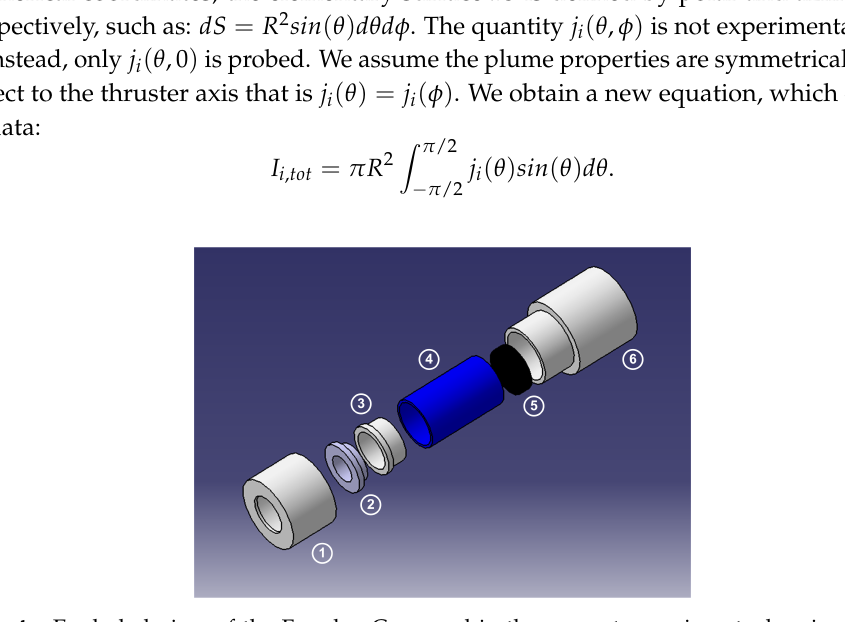
Figure 4. Exploded view of the Faraday Cup used in the present experiment, showing the main elements (see [29] for more